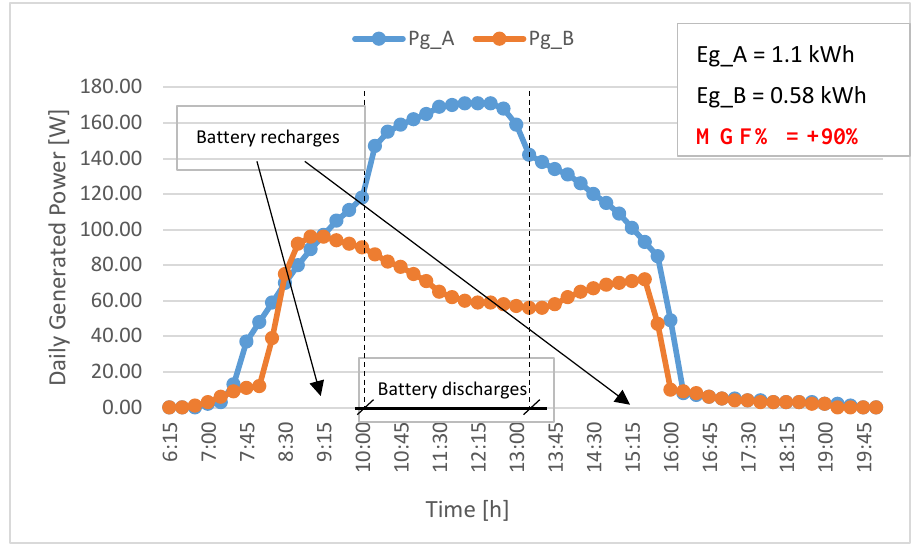
Figure 12. Daily power generation curves, Pg_A and Pg_B, of the two prototypal PV generators A Figure 12. Daily Power generation curves, Pg_A and Pg_B, of the two prototypal PV-generators A and B 435 and B on an August 2021 cloudless day, together with the corresponding daily generated energy on an August 2021 cloudless day together with the corresponding daily generated energy values, Eg_A 436 values, Eg_A and Eg_B, and the percentage major generation factor, MGF%. In this experiment, two and Eg_B and the percentage major generation factor, MGF%. In this experiment, two identical shading 437 identical shading plywood sheets were mounted on three PV cells of both homemade submodules of plywood sheets have been mounted on three PV-cells of both the homemade sub-modules of the PV- 438 the PV generator A and B. On the submodule of the PV generator A, the battery control unit was generator A and B. On the sub-module of the PV-Generator A the battery control unit was activated while 439 activated while the bypass-diode of the submodule of the PV generator B did not intervene. the bypass-diode of the sub-module of the PV-Generator B did not intervene. 440